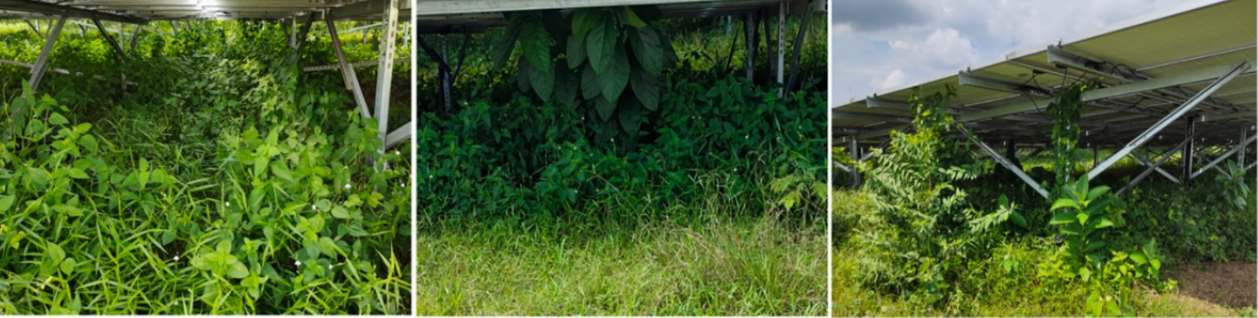
Figure 2. Improper weed management on LSS farms.